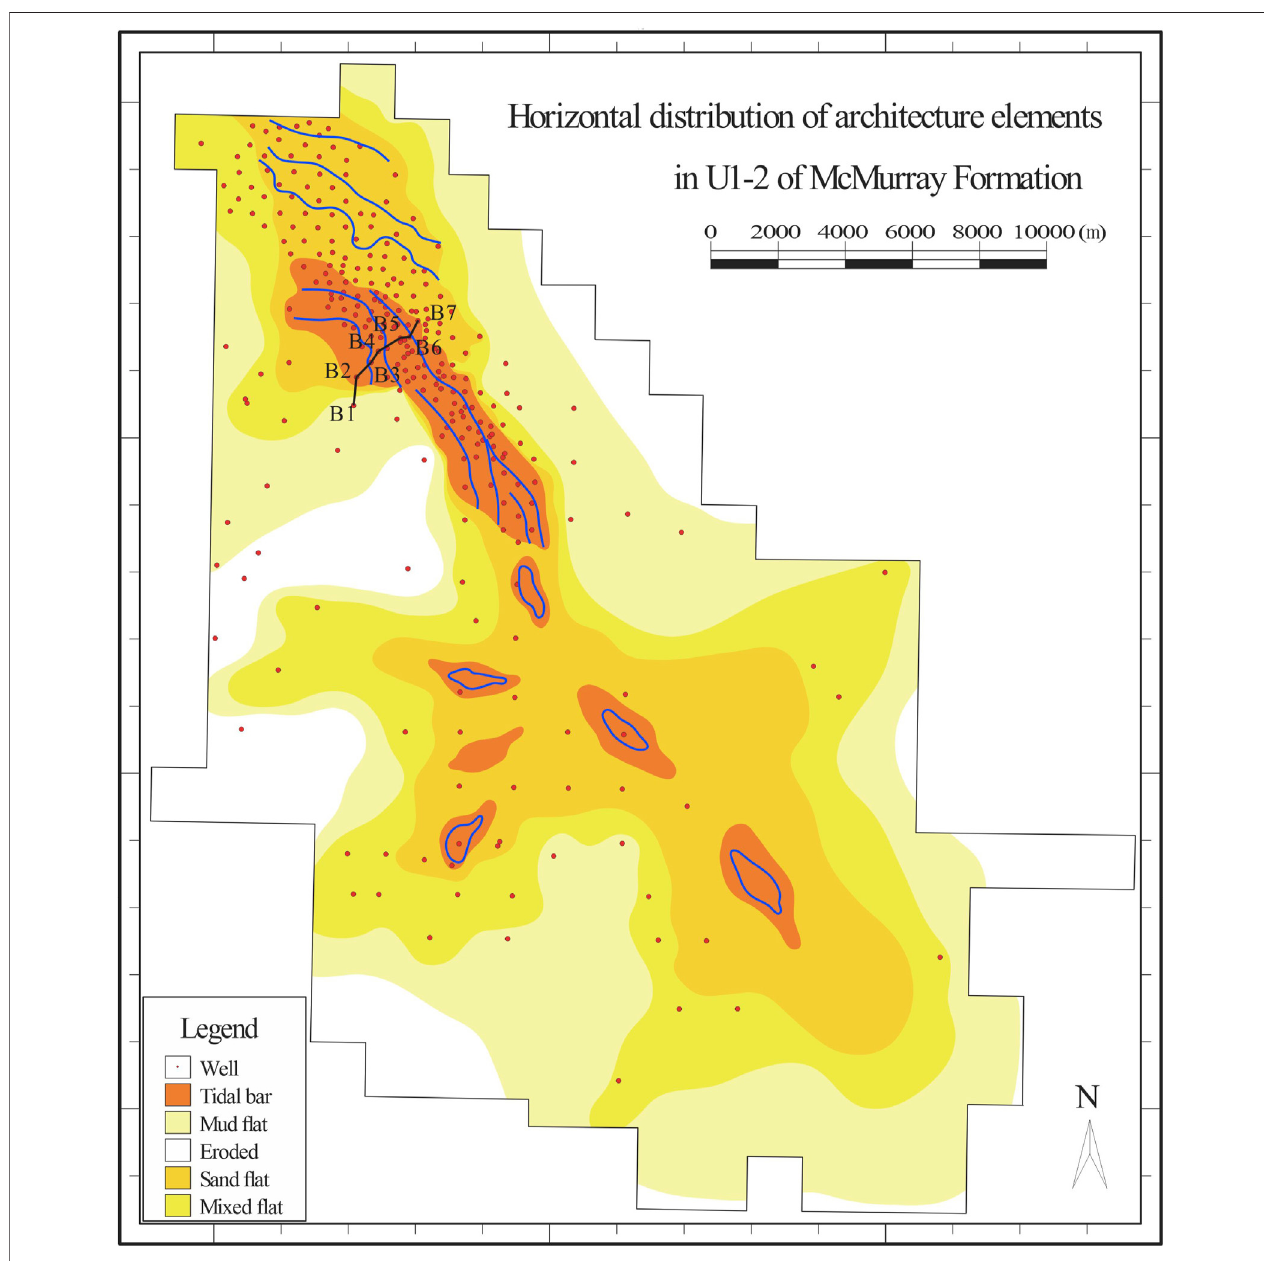
FIGURE 7 | Map view of the architecture pattern in U1-2 of McMurray Formation. The blue dotted line in tidal bars represented the periods of tidal bars, indicating that the large-scaled tidal bar compounds consisted of lateral accretion.